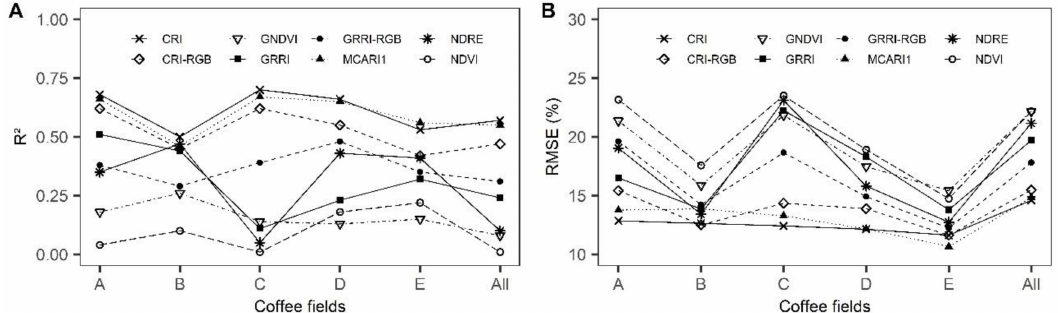
Figure 7. Statistical metrics of the linear models for coffee ripeness estimation: ( A ) determination coefficient (R 2 ); and ( B ) root mean square error (RMSE).